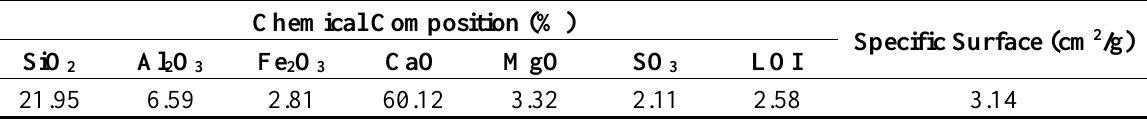
Table 4. Chemical composition and physical properties of cement. LOI: Loss on ignition.